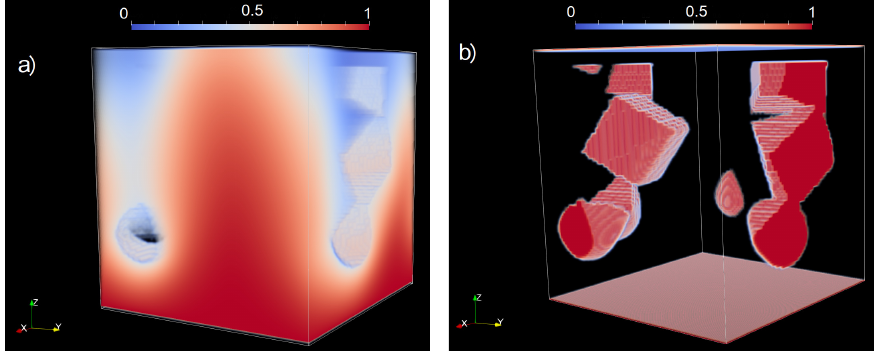
Figure 7. Solvent and mineral distributions during an intermediate Peclet number (Pe = 10) flow. ( a ) Solvent concentration and ( b ) mineral